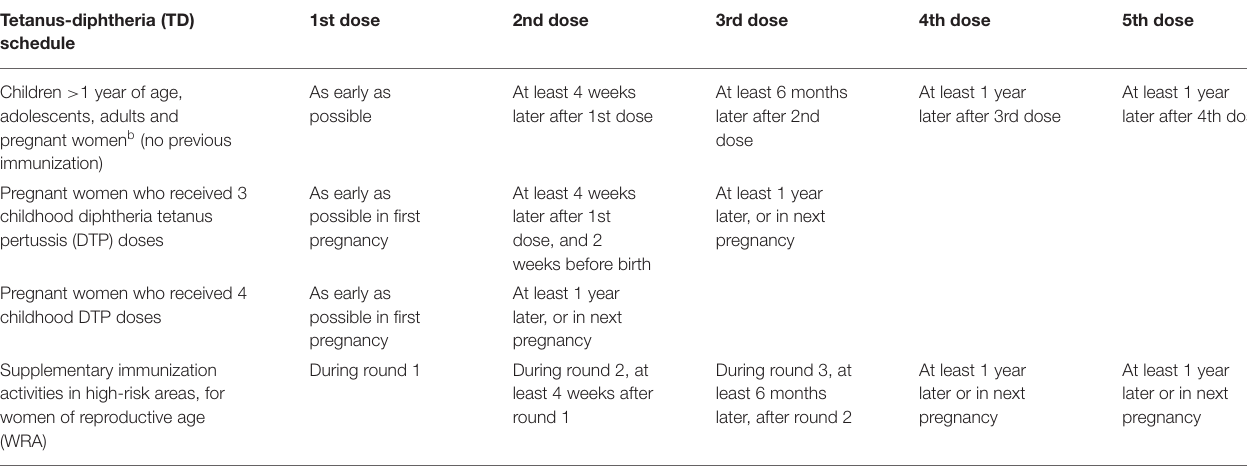
1st dose 2nd dose 3rd dose 4th dose 5th dose